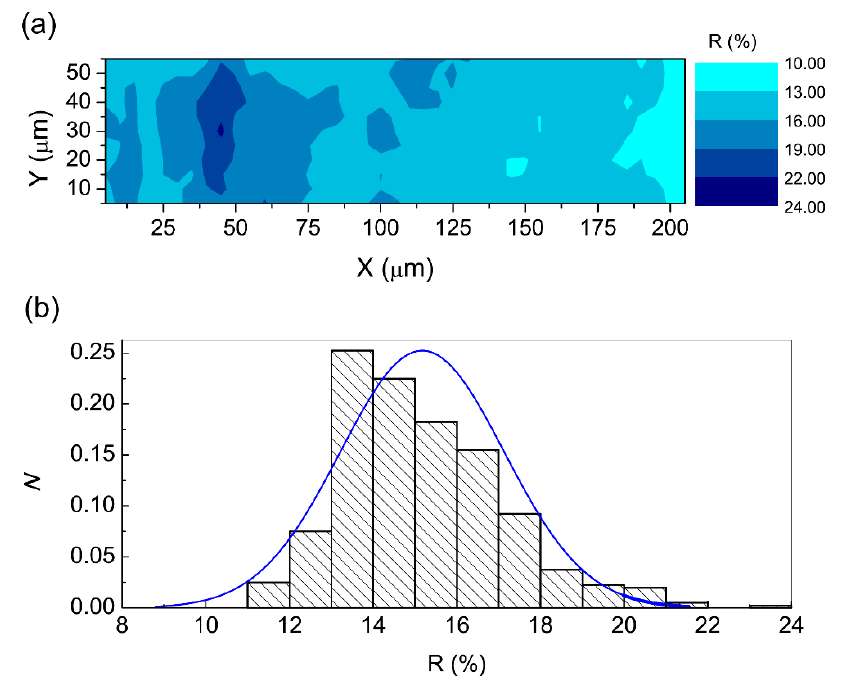
Figure 12. ( a ) Film reflectivity map. ( b ) Histogram of the density of sampled cells for a unit bin interval with a normal distribution fit (blue line) to data. Reproduced with permission from [101]. Copyright © 2022, EDP Sciences, Springer-Verlag GmbH Germany, part of Springer Nature Copyright 2019.